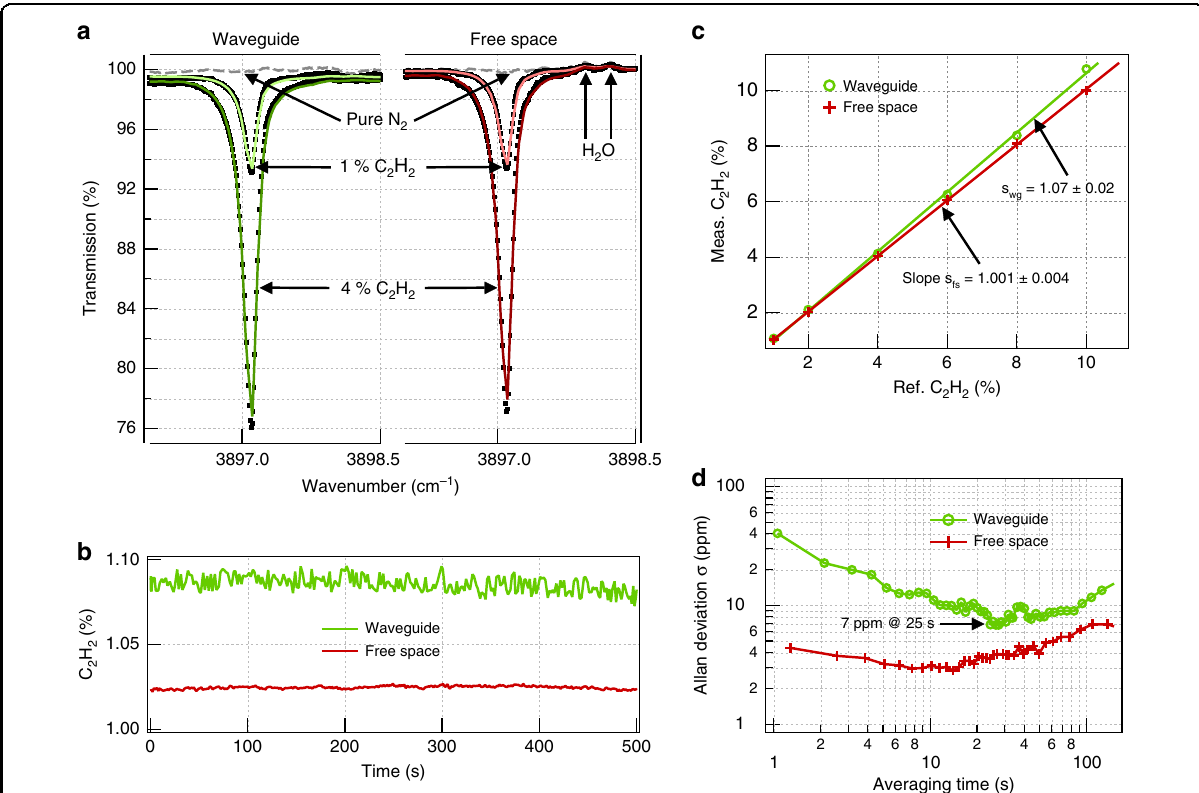
Fig. 4 Spectroscopic measurements with acetylene. a Transmission spectra (square symbols) and PNNL fi ts (solid lines) at different concentrations of C 2 H 2 in N 2 measured with a 2 cm long waveguide (left) and in free space of equal pathlength (right). The spectra are normalized to the transmittance with dry N 2 (gray dashed lines). b Concentration time series for 1% C 2 H 2 obtained from real-time spectral fi tting with PNNL free-space reference spectra. c Measured C 2 H 2 concentrations versus reference. The ratio s wg /s fs yields the evanescent fi eld con fi nement factor in air as Γ = 107 ± 2% free from systematic error that may occur due to uncertainty in the calibration gas concentration or dilution. d Allan deviation plot corresponding to the concentration data time series shown in b . LOD of 7 ppm after 25 s averaging achieved with the waveguide translates into the absorption noise of 4.5 × 10 −